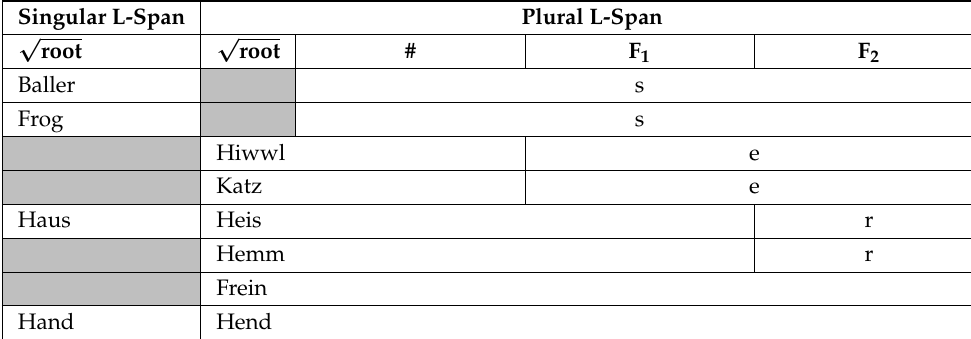
Table 4. Summary of L-spans associated with PD Singular